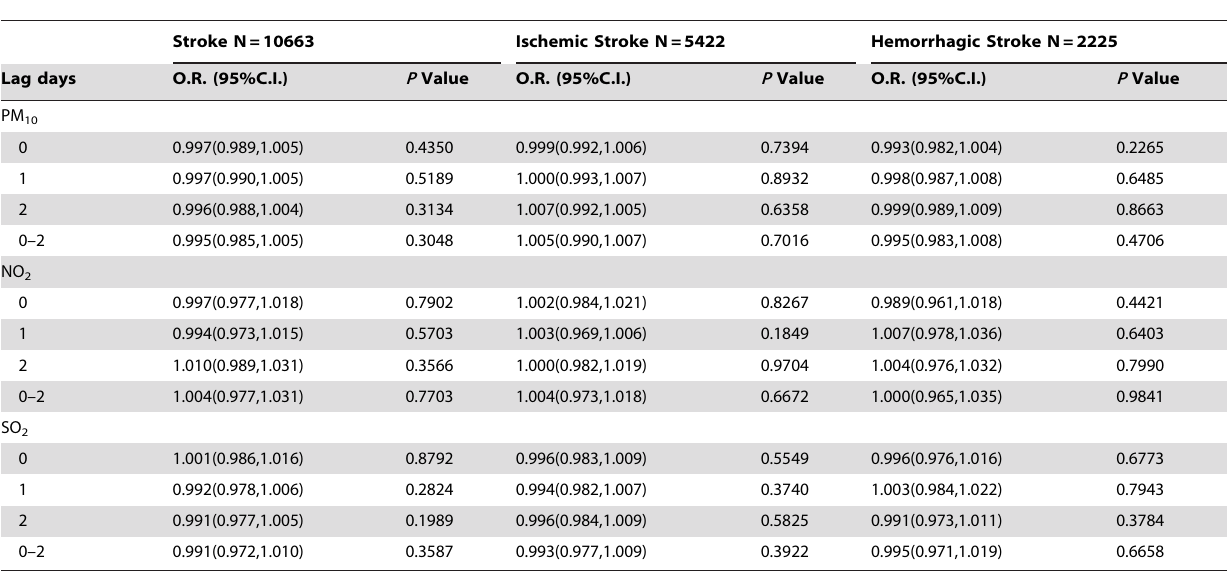
Table 2. Association of all strokes, ischemic and hemorrhagic strokes and pollutant concentrations by lag days for 10 m g/m 3 increases in pollutant levels adjusted for temperature and humidity, Wuhan,